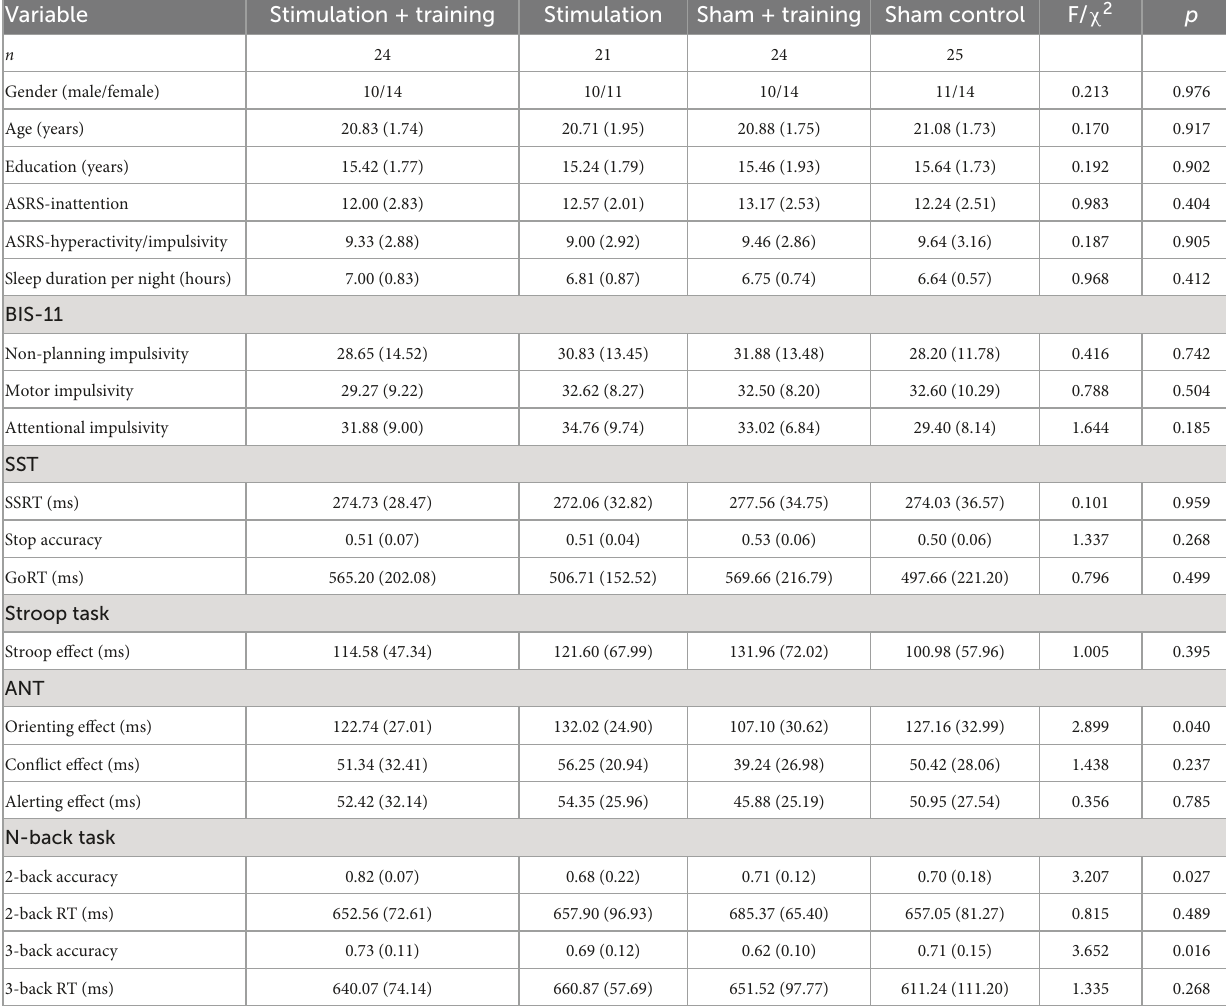
TABLE 1 Demographic data, scale scores, and behavioral tasks performance at baseline.